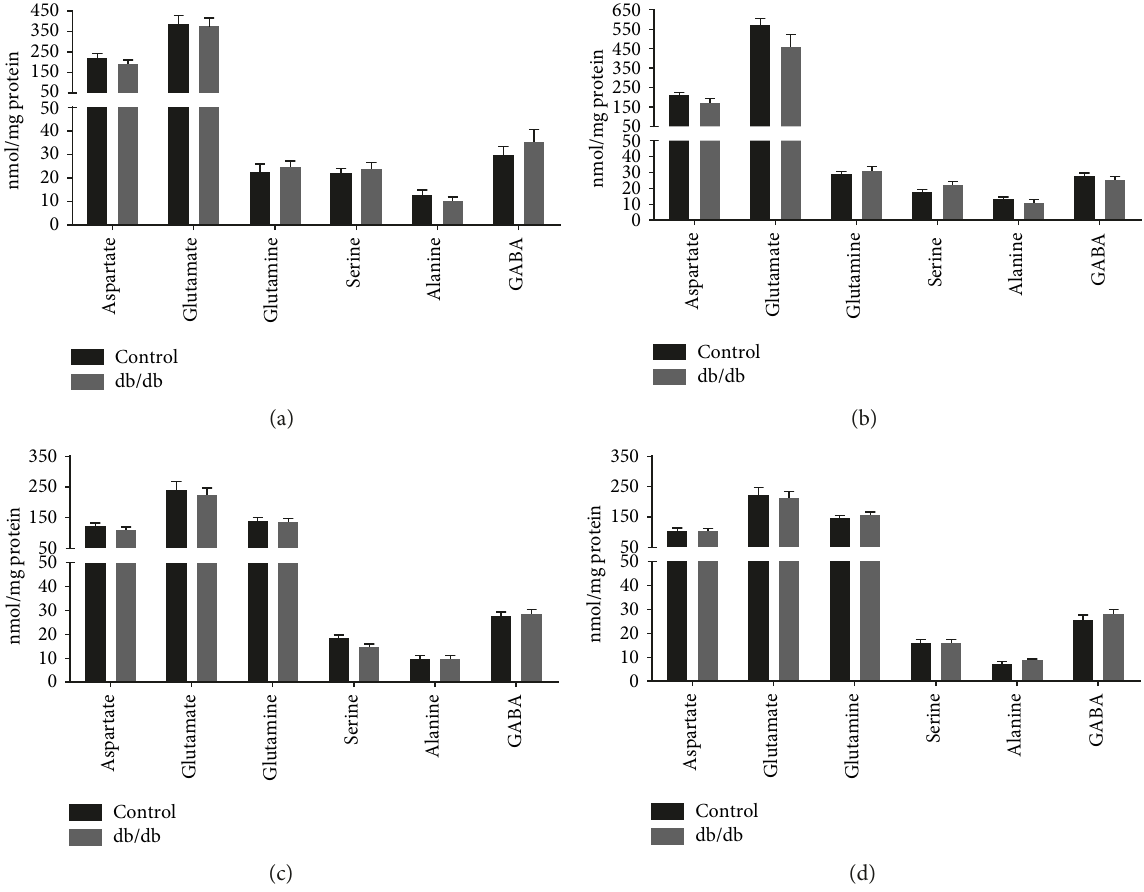
Figure 3: Amino acid amounts in extracts of cerebral cortical and hippocampal slices of control and db/db mice. Amino acid amounts of cerebral cortical (a and c) and hippocampal (b and d) slices of control and db/db mice incubated in media containing either [U- 13 C]glutamate (a and b) or [U- 13 C]glutamine (c and d). Results are presented as means ± SEM, n = 8 – 11 , Student ’ s t -test, p < 0 05